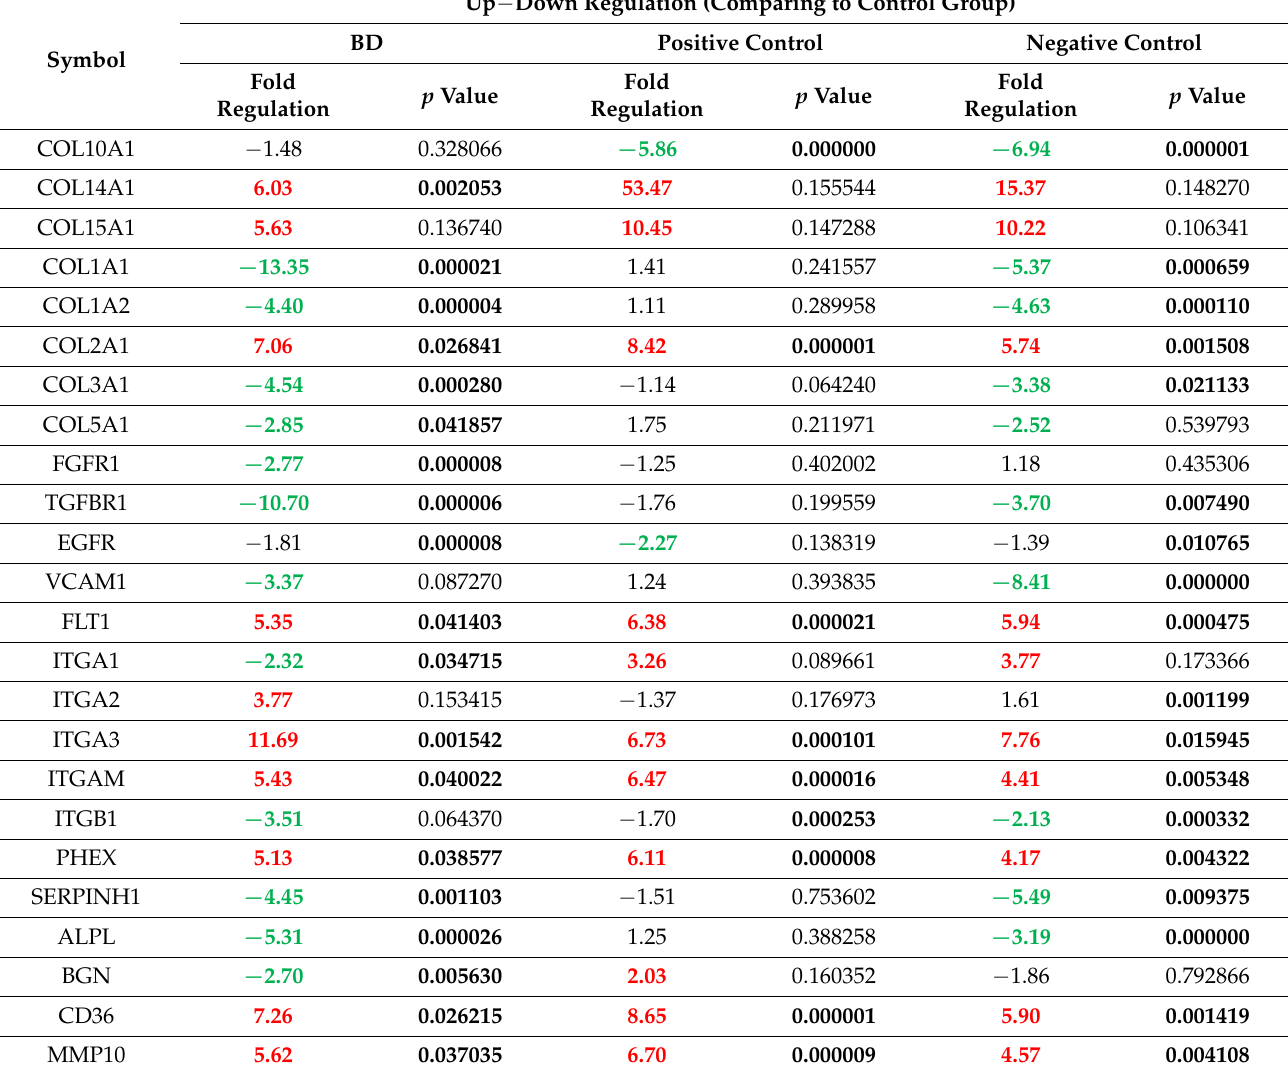
Table 2. PCR array results of fold changes and the statistical significance of genes which are involved in extracellular matrix-related gene clusters during odonto/osteogenic differentiation. All groups were compared to day 1of treatment. Red: upregulated genes, Green: Downregulated genes. The bold numbers represent significant p